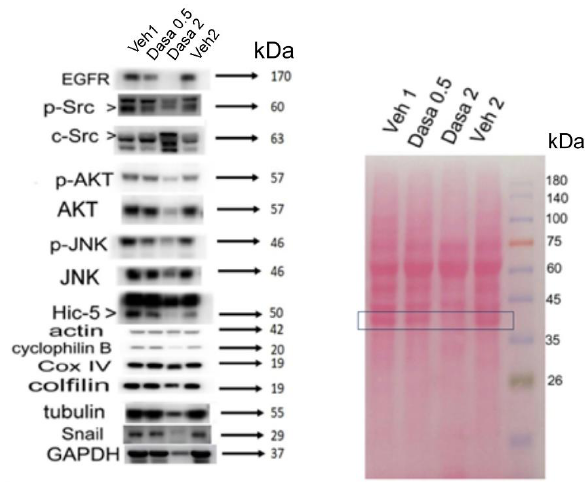
Figure 4. Signal molecules suppressed in HuCCT1 tumors treated with dasatinib. The tissue lysates of HuCCT1 tumors harvested from SCID mice skins treated with vehicles (Veh1 and Veh2) and dasatinib at indicated concentration (Dasa 0.5 and Dasa 2 mg/g mouse, paired with Veh1 and Veh2, respectively) were extracted for a Western blot of the indicated molecules (left panel). Ponceau S staining of the blot (right panel) was demonstrated as a loading control. In the right panel, blue rectangles enclose the band close to 37 kDa, suspected of GAPDH, which was shown to be decreased in dasatinib (2.0 mg/g)-treated samples in a Western blot. The data shown are representatives of two reproducible